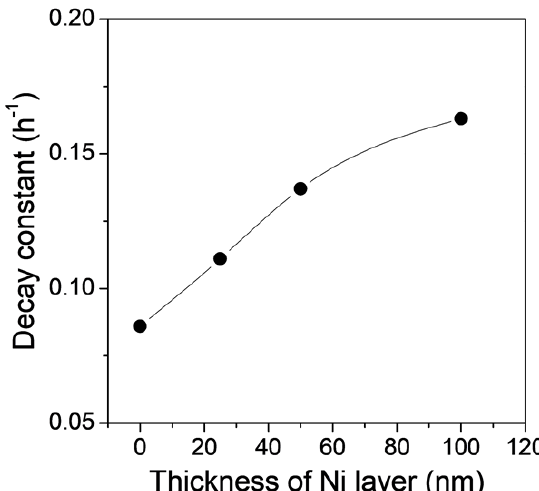
Figure 6. Dependence of MB decay constant on the thickness of Ni underlying layer for anatase TiO 2 films grown on Ni/Ti coated glass. The data are extracted from curves in Figure 4.